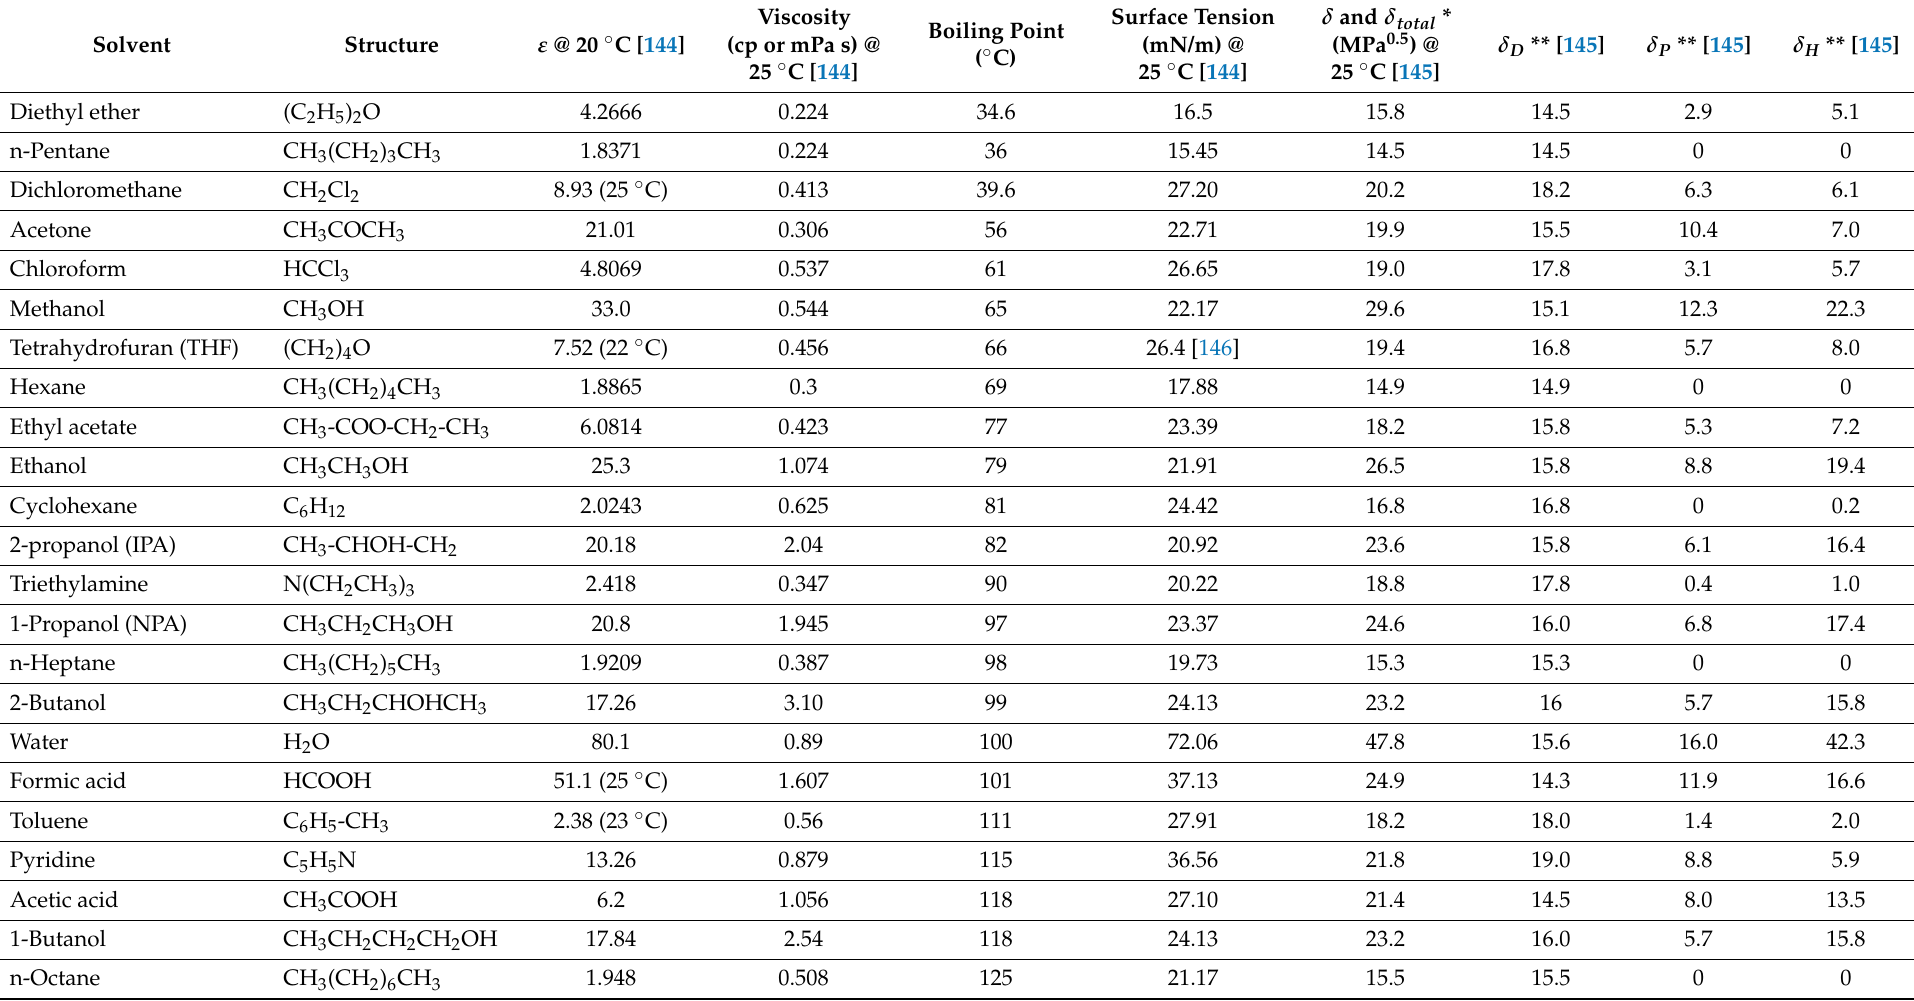
Table 2. The dielectric constant ( ε ), viscosity, boiling point, surface tension and solubility parameters ( δ and δ total ) of the solvents commonly used in catalyst ink and the solvents that have been used in the literature to prepare catalyst ink (arranged by boiling point), and the solubility parameters of several